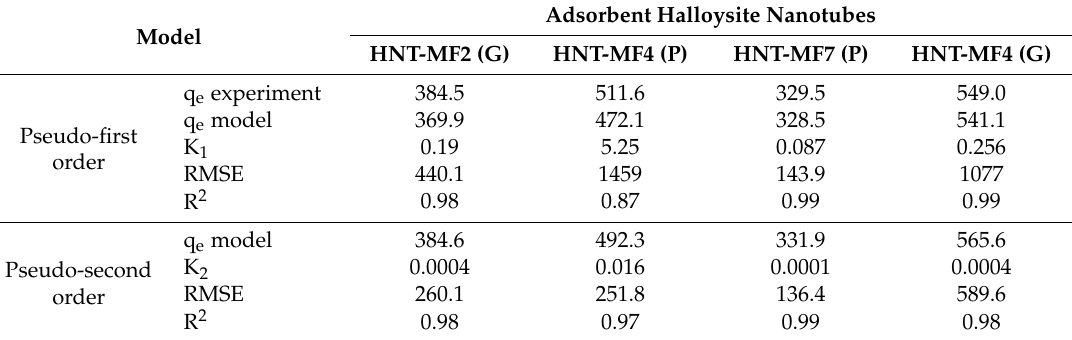
Table 2. Pseudo-first and second order parameter values of phosphate adsorption onto different